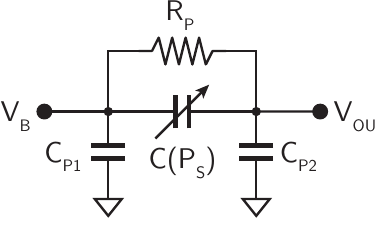
Figure 3. Equivalent circuit of a MEMS